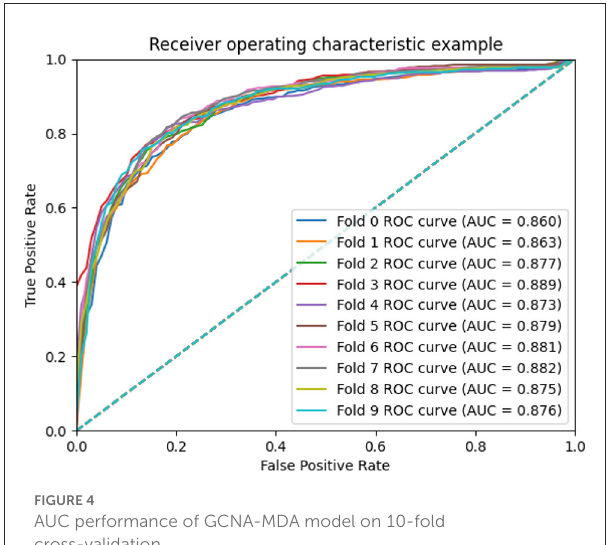
random factors. In order to further eliminate the interference of other factors, our GCNA-MDA model was subjected to a 10-fold cross-validation experiment on the HMDD dataset. Figure 4 shows the AUC performance of 10-fold cross-validation. The GCNA- MDA model achieved AUC values of 0.860, 0.863, 0.877, 0.889, 0.873, 0.879, 0.881, 0.882, 0.875, and 0.876 in 10 experiments. It can